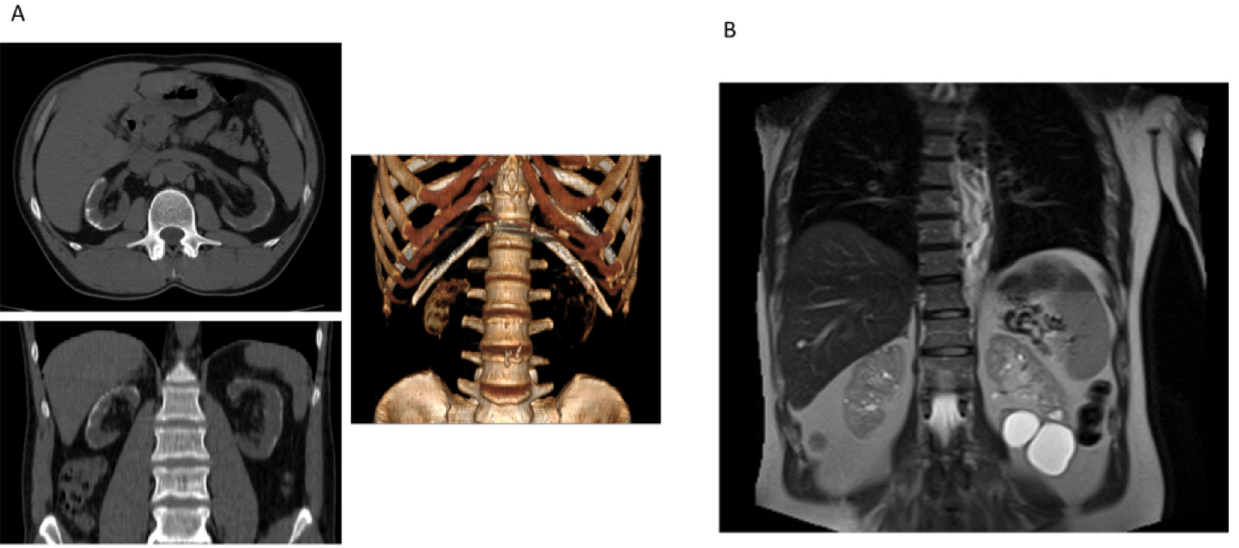
Figure 5. ( A ) Case 2 computed tomography (CT), in axial (upper) and coronal (low) planes, showing cortical and circumferential calcifications. The image on the right shows that the renal cortex has a density similar to the bone, further indicating the diagnosis of cortical nephrocalcinosis. ( B ) Case 3 abdomen CT showing subcentimetric cysts on the right and larger cysts on the left kidney.